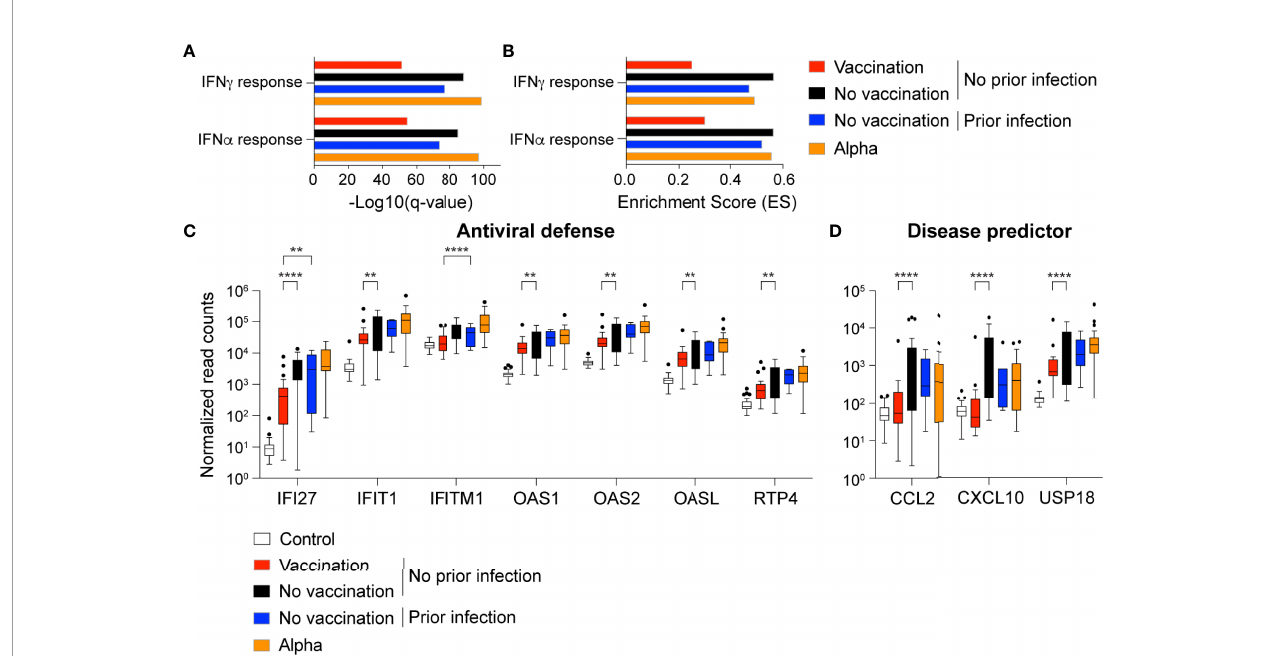
FIGURE 3 | Immune transcriptomes following Omicron infection. (A, B) Gene categories expressed at signi fi cantly higher levels in unvaccinated and vaccinated Omicron patients without prior SARS-CoV-2 infection, unvaccinated Omicron patients with prior SARS-CoV-2 infection, and a reference group of patients infected by the SARS-CoV-2 Alpha variant were signi fi cantly enriched in interferon-activated and in fl ammatory pathways. X-axis denotes statistical signi fi cance as measured by minus logarithm of FDR q-values (A) and enrichment score (ES) (B) , respectively. Y-axis ranked the terms by q values (A) or enrichment score (B) . (C, D) Bar plots with the normalized read counts to mRNA levels of fi fteen innate immune response genes of the 23 genes that are signi fi cantly induced in all cohorts and higher in the ‘ no vaccination group ’ compared to ‘ vaccination group ’ (C) and seven that are signi fi cantly induced in the ‘ no vaccination ’ group, but not ‘ vaccination group ’ , and higher in No vaccination group compared to Vaccination group (D) . Asterix shows signi fi cance between Omicron groups, and signi fi cance between healthy control and COVID-19 groups left out. p -value are from 2-way ANOVA with Tukey ’ s multiple comparisons test. ** p < 0.01, **** p < 0.0001. Median, middle bar inside the box; IQR, 50% of the data; whiskers, 1.5 times the